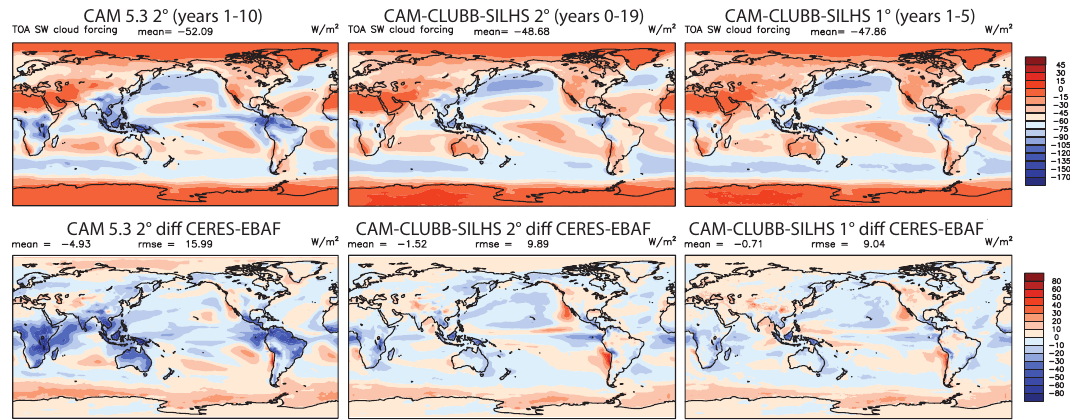
Figure 5. Top-of-the-atmosphere shortwave cloud forcing (SWCF) for CAM 5.3 (left), CAM-CLUBB–SILHS 2 ◦ (center), and CAM- CLUBB–SILHS 1 ◦ (right). The difference from CERES-EBAF observations of SWCF is shown in the second row. CAM-CLUBB–SILHS reduces the SWCF low bias over tropical land regions seen in CAM 5.3.